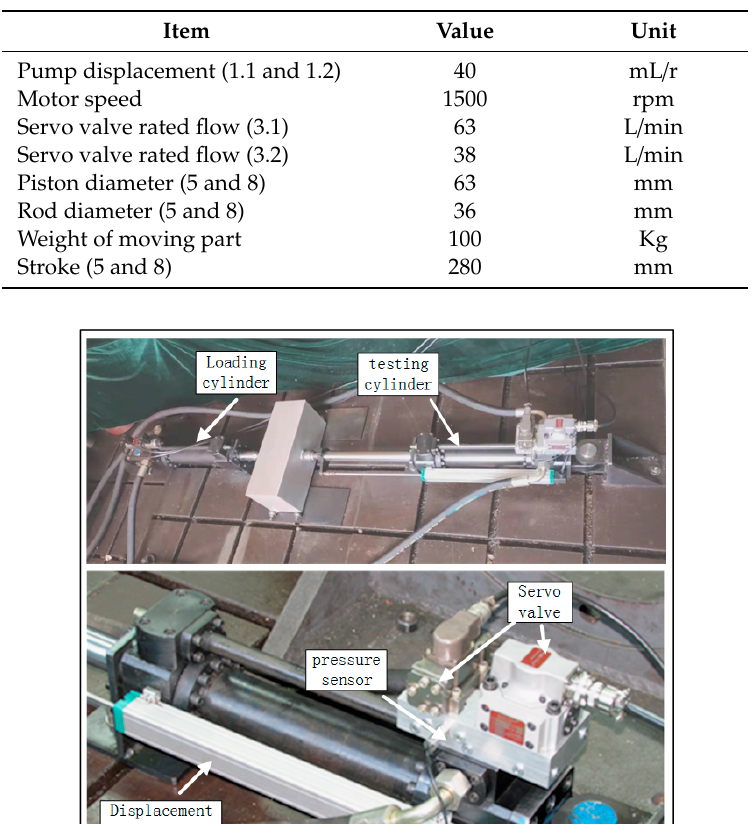
Table 1. Main Specifications of the Test Rig.